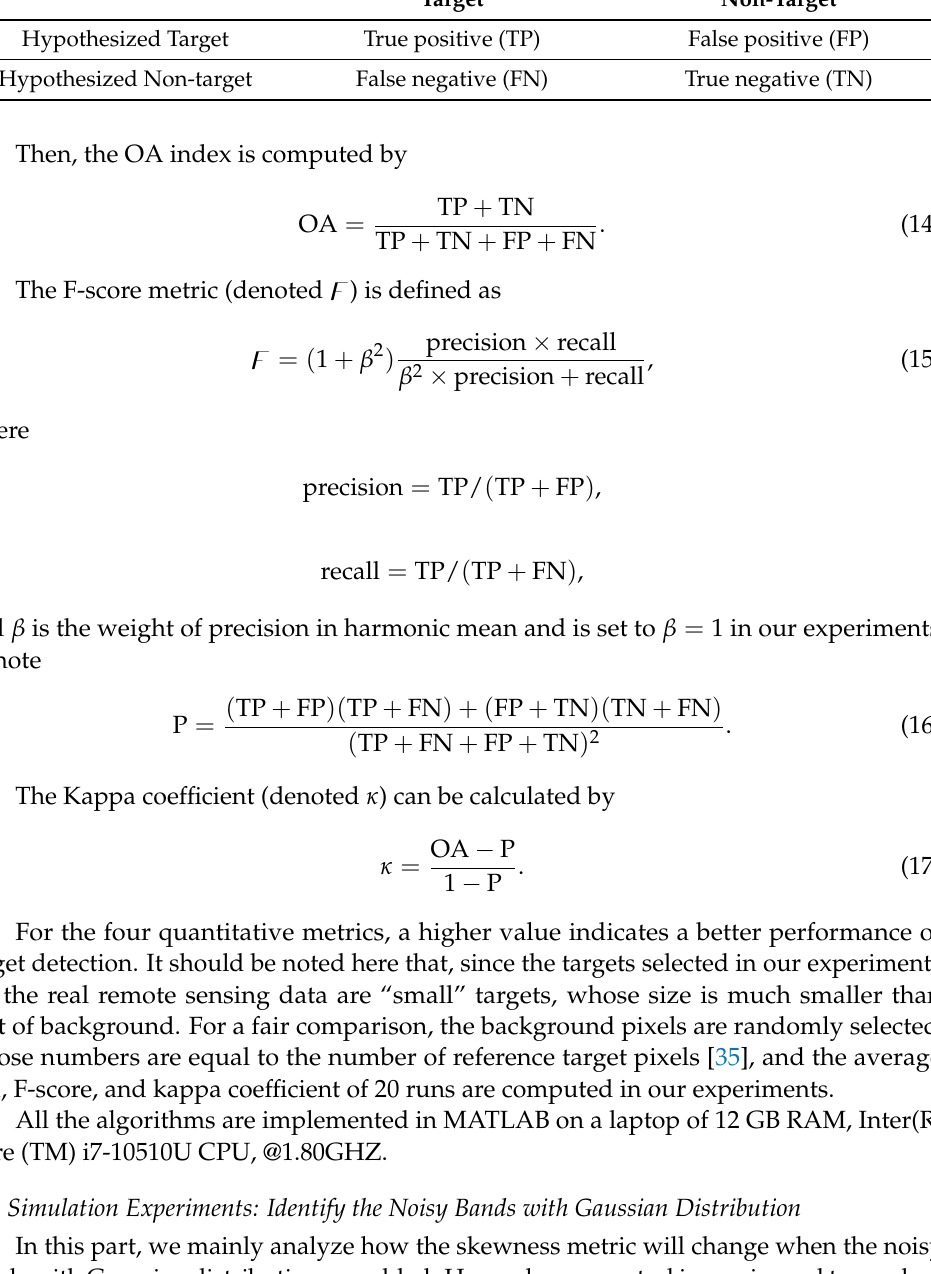
Table 2. Illustration of the confusion matrix of a binary classification.